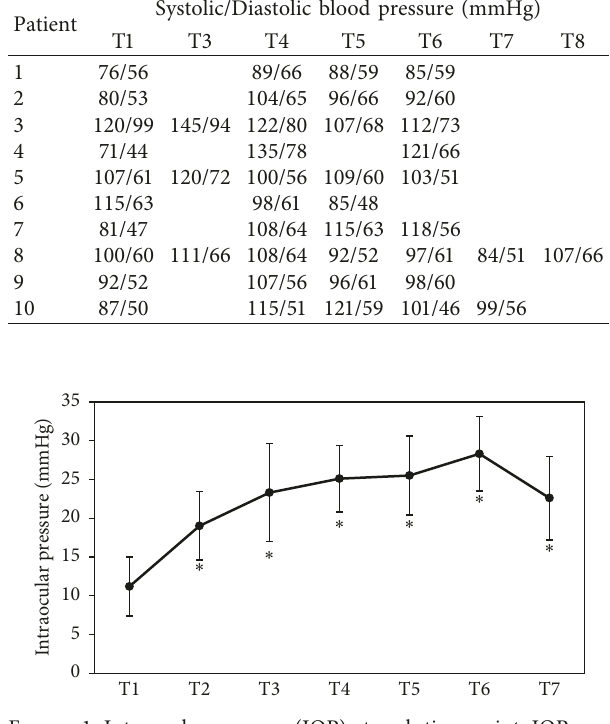
Figure 1: Intraocular pressure (IOP) at each time point. IOP was increased during RALP. ∗ P < 0 . 001 compared with T1.